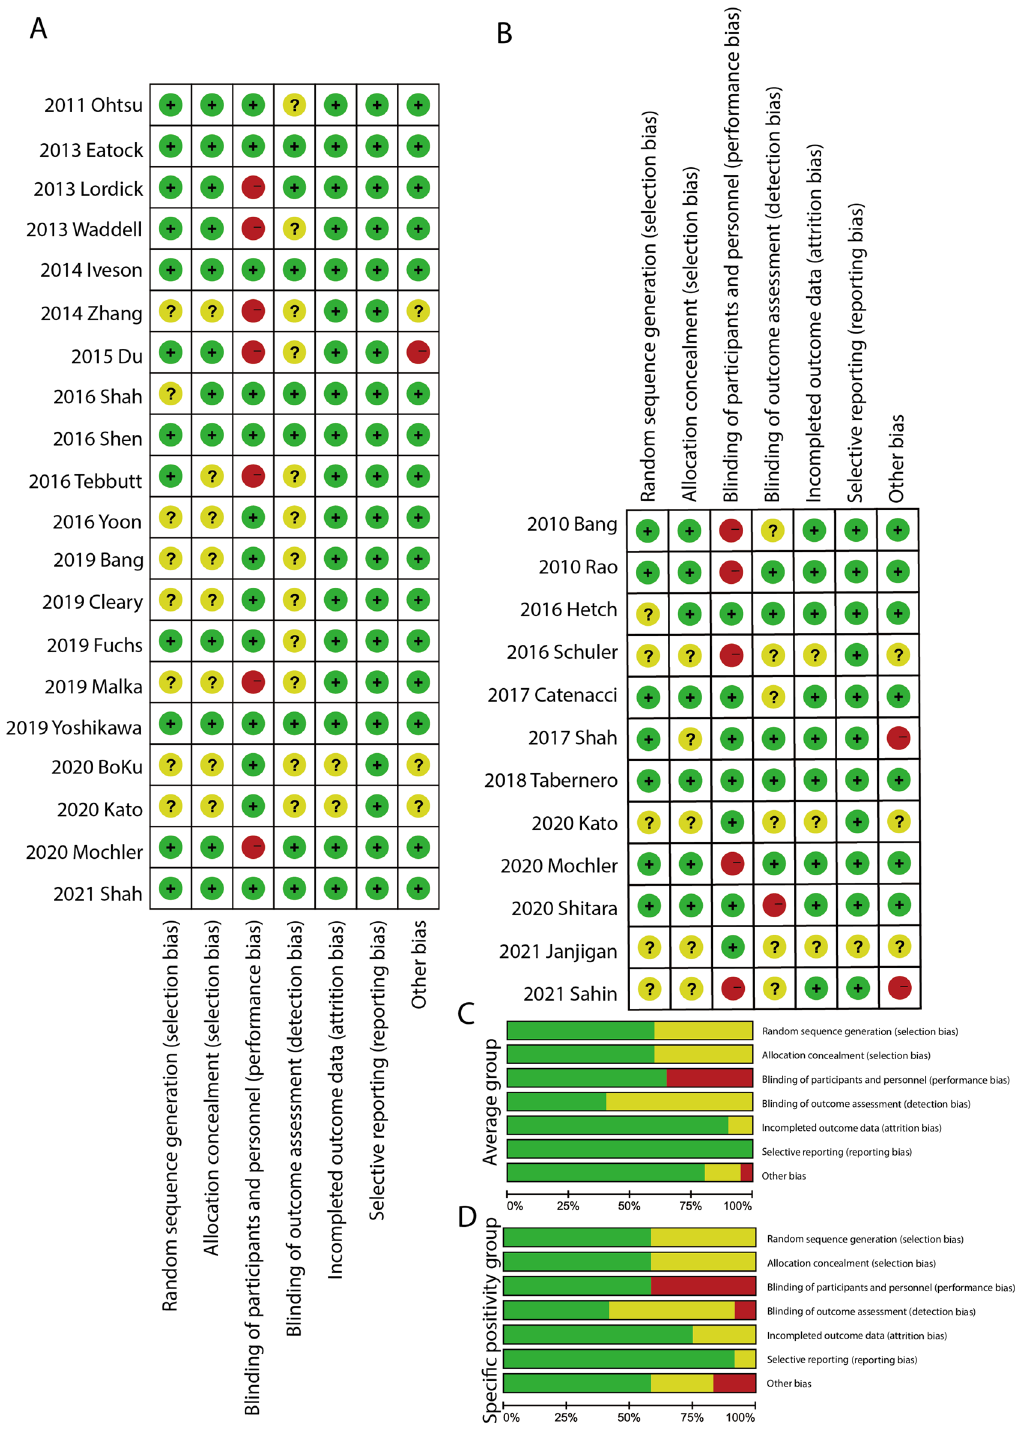
Figure 3. Risk of bias assessment. ( A ) Risk of bias assessment plots in average group; ( B ) Risk of bias plots assessment in specific positivity group; ( C ) Risk of bias proportion in average group; ( D ) Risk of bias proportion in specific positivity